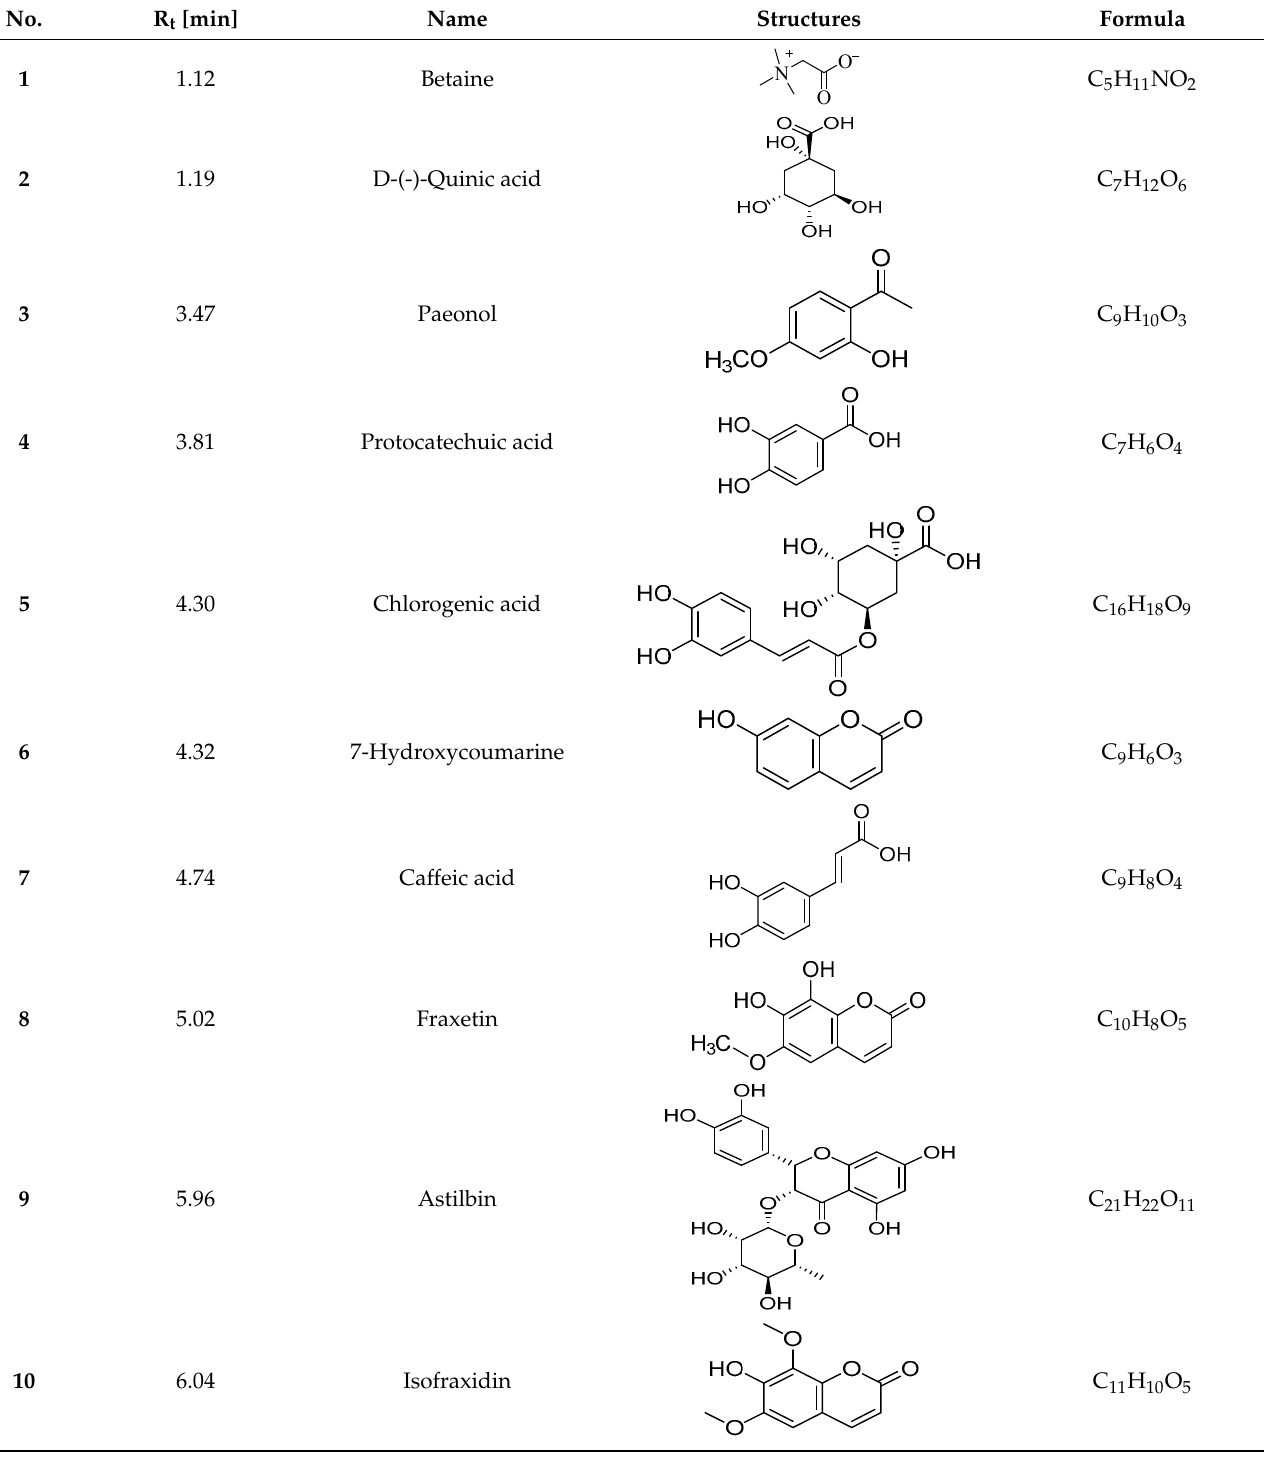
Figure 2. The chemical profile of SG extracts analyzed by UPLC-MS (negative). The numbers indi- cate the compounds. Table 2. The main active ingredients of SG extracts. No. R t [min]